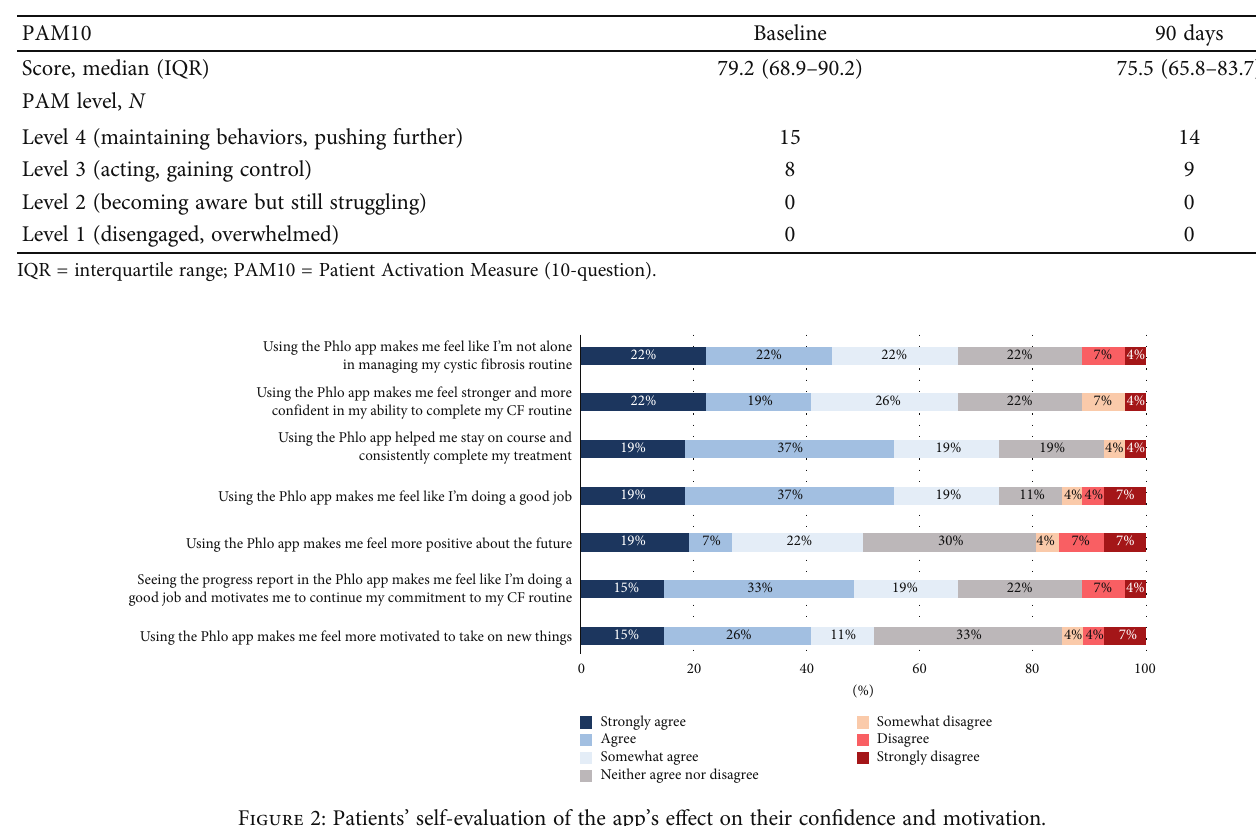
Table 3: Patient activation measures ( N = 23 ).